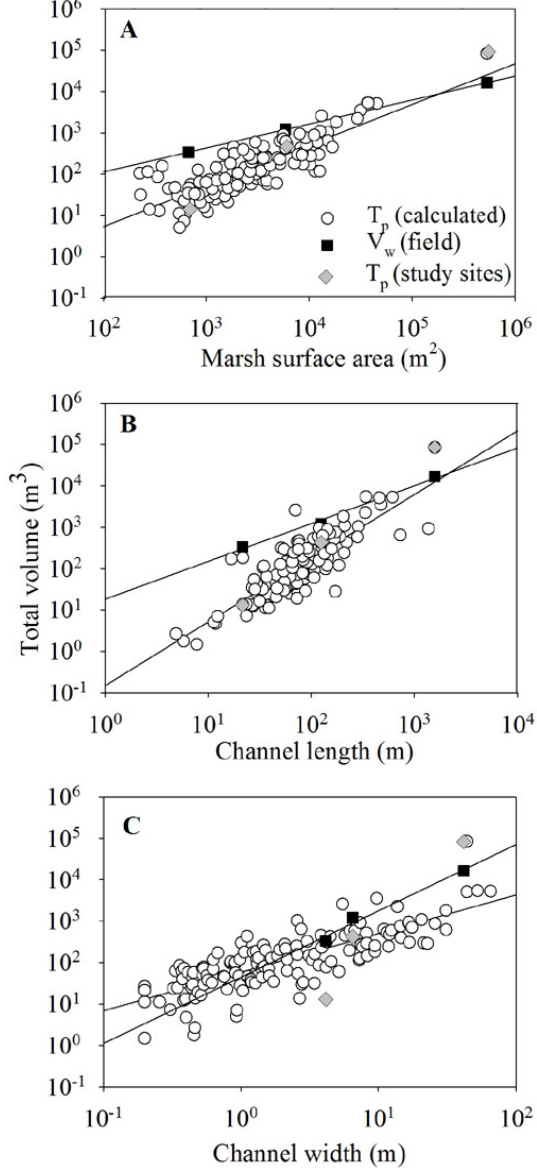
Fig. 6. Relationship of calculated tidal prism to (A) marsh surface area, (B) channel length, and (C) inlet channel width. Field mea- surements are shown as black squares; gray diamonds highlight pre- dicted tidal prism for the corresponding study